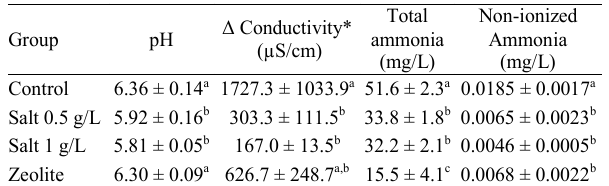
Table 2. Blood glucose levels in Ancistrus triradiatus before and after transport in plastic bags. N=10. † Data not taken because of the insufficient number of animals. Data are expressed as mean ± standard deviation. * indicate significant difference from before transport. Different capital letters indicate significant difference between groups in the same sampling